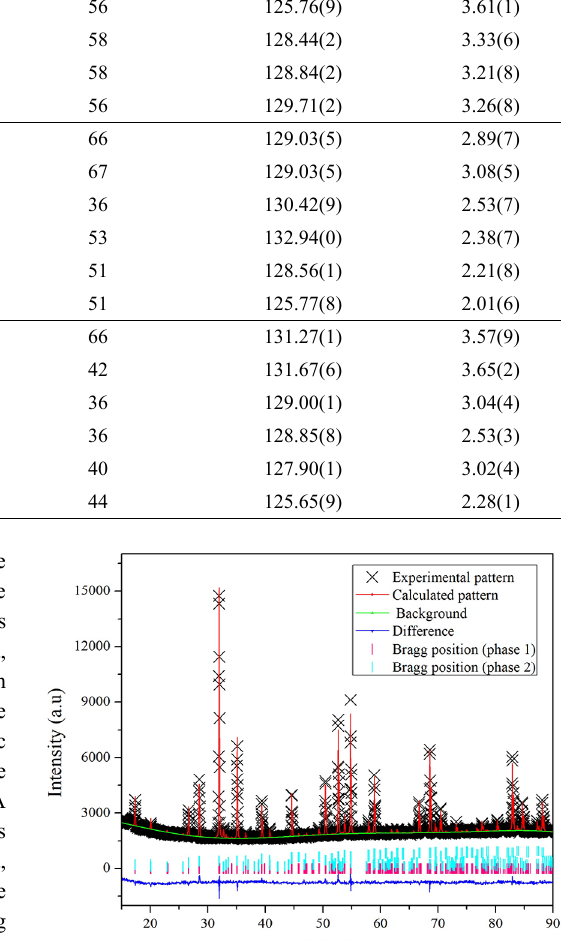
Figure 6. Rietveld refinement results for sample Sm